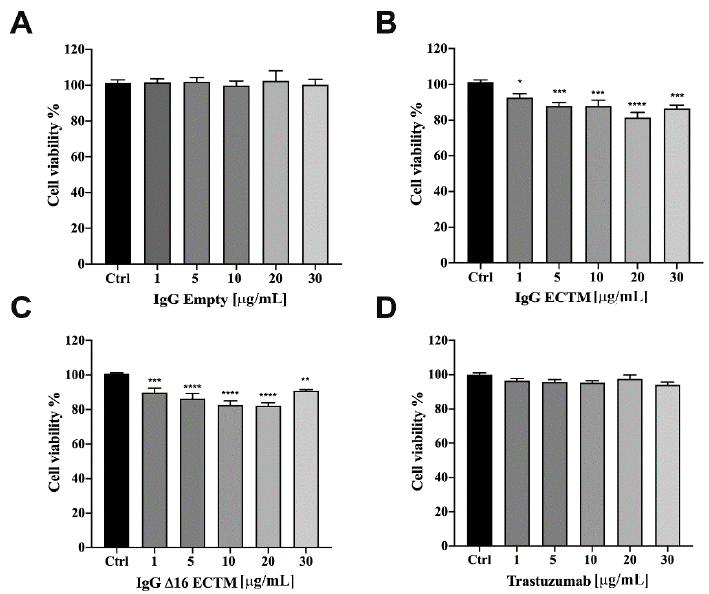
Figure 7. IgG purified from ECTM- and Δ 16ECTM-immune sera decreased cell viability in trastuzumab-resistant BT-474.R BC cells. Cells were incubated for 72 h in the presence of increasing concentrations of control IgG ( A ) or ECTM-IgG ( B ) or Δ 16ECTM-IgG ( C ) or trastuzumab ( D ) and cell viability was determined by MTT assay. The results are expressed as percentage of living cells ± SEM with respect to control (untreated cells). Columns report the means of mean of three separate experiments, wherein each treatment was repeated in 6 wells. One-way ANOVA followed by Dun-